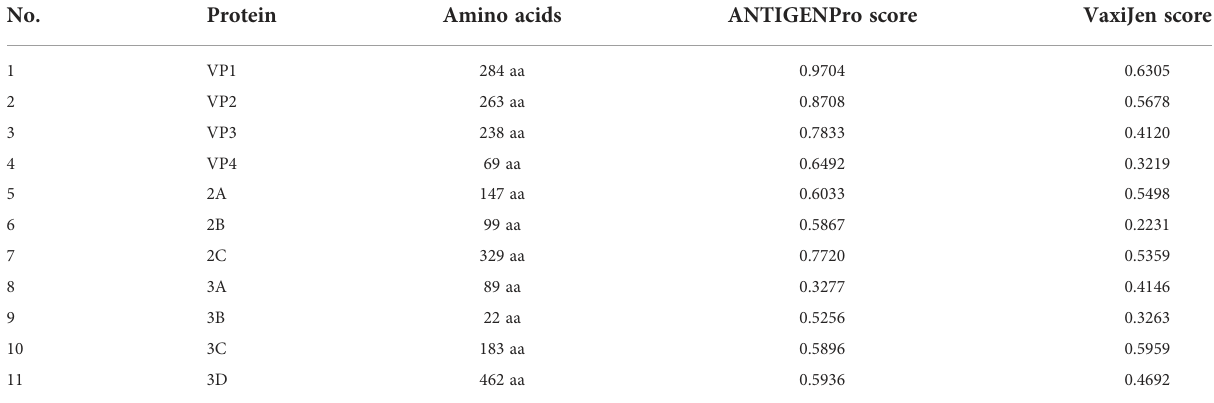
TABLE 1 Details and antigenic value of the CVB proteins.